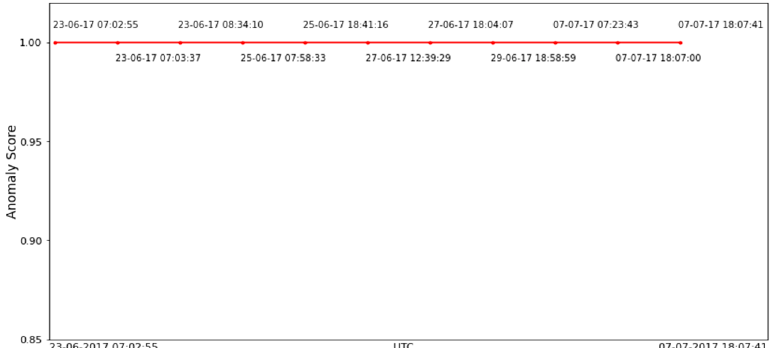
Figure 7. CLOP anomaly score of anomalies and rare